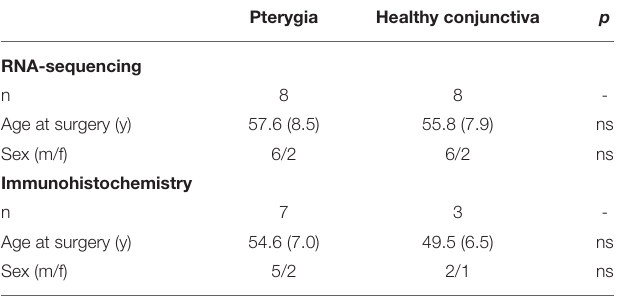
TABLE 1 | Demographic data.